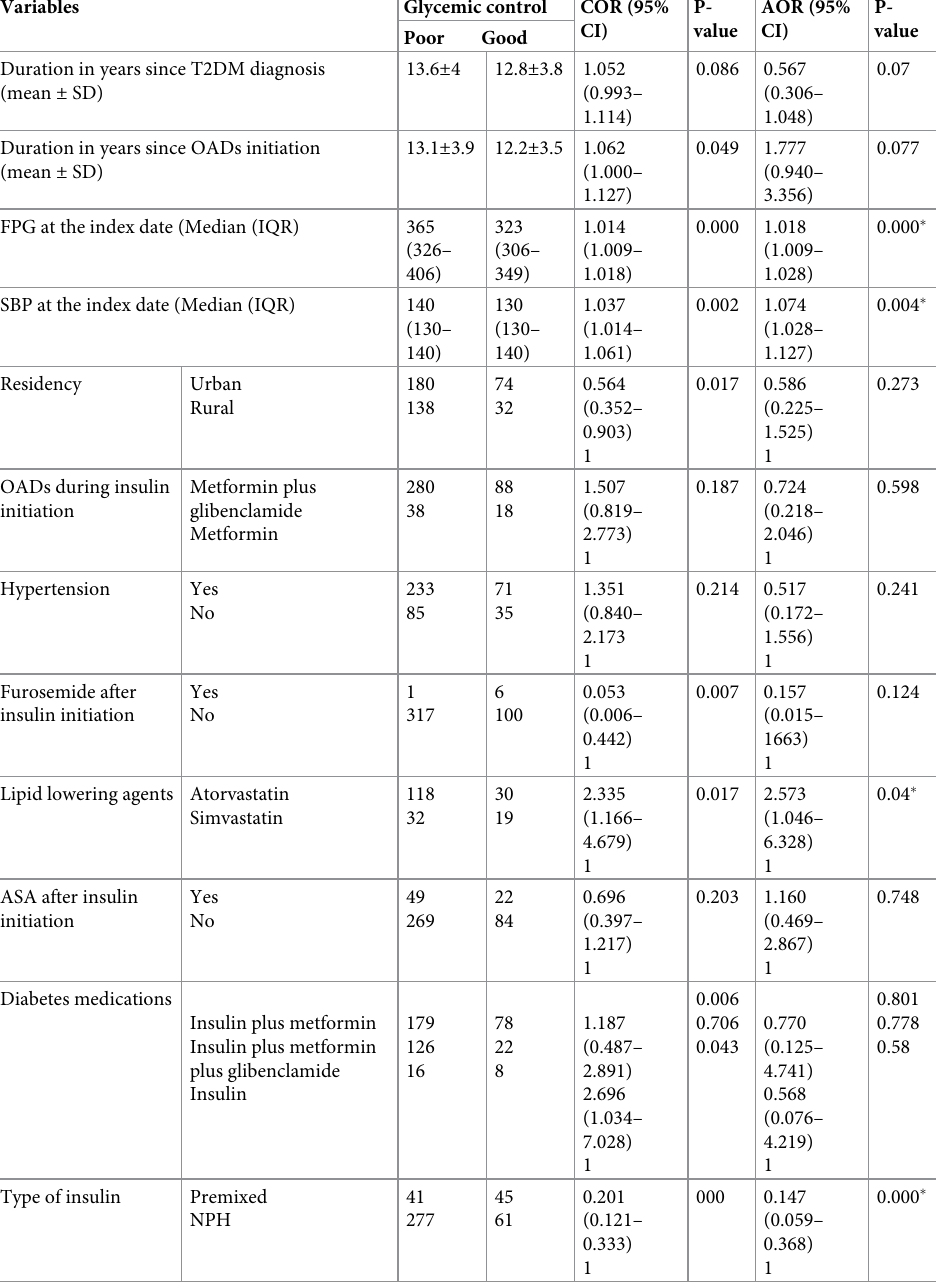
Table 3. Association of variables with poor glycemic control after insulin initiation.